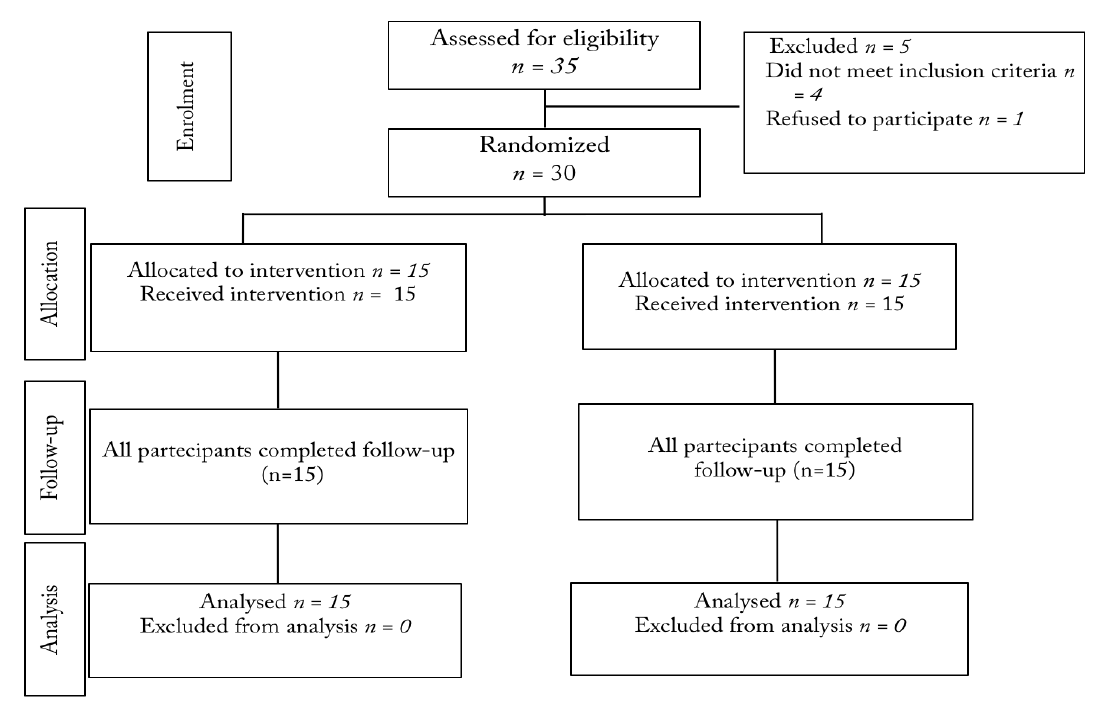
Figure 1 . CONSORT flow diagram of the study. The final number of participants analysed is based on the principle of complete case analysis and intention-to-treat